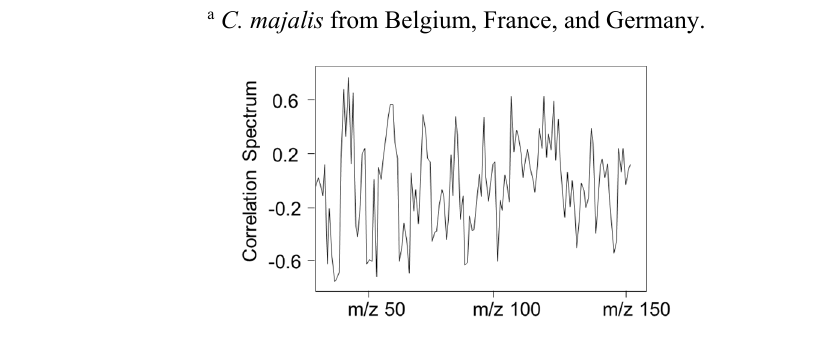
Figure 5. Correlation spectrum associated with the PLS-DA (Partial Least Squares-Discriminant Analysis) classification of C. majalis from The Netherlands and other countries presenting the relevance of particular masses analyzed by PTR-MS for the